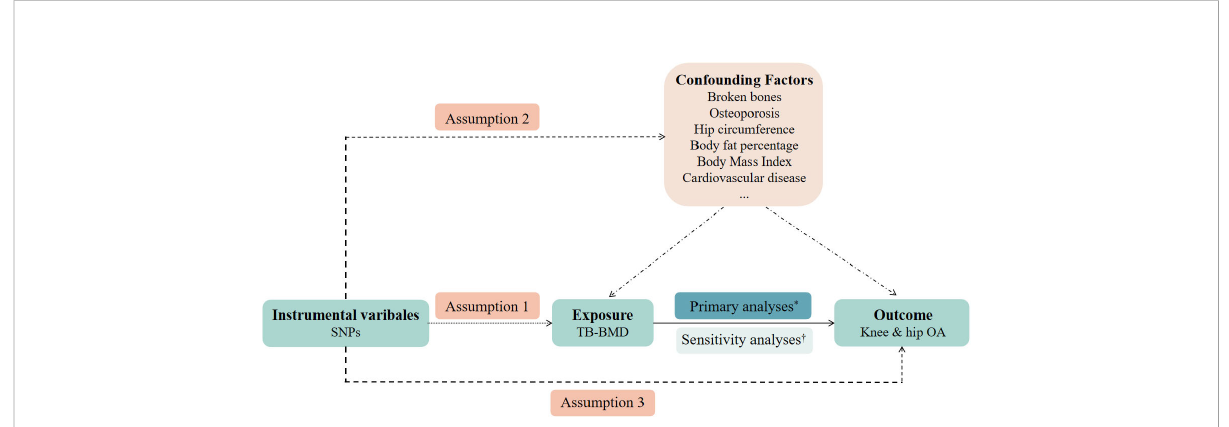
FIGURE 1 An overview of the study design. SNP, single-nucleotide polymorphism; TB-BMD, total body bone mineral density; OA, osteoarthritis. Assumption 1: the instrumental variables (IVs) must be robustly associated with the exposure. Assumption 2: the IVs must not be associated with any confounding factors of the exposure-outcome relationship. Assumption 3: the IVs must only affect the outcome through the exposure. *Primary analyses: inverse-variance weighted (IVW) method, weighted median estimator, and MR-Egger regression. † Sensitivity analyses: cochran ’ s Q test and leave-one-out